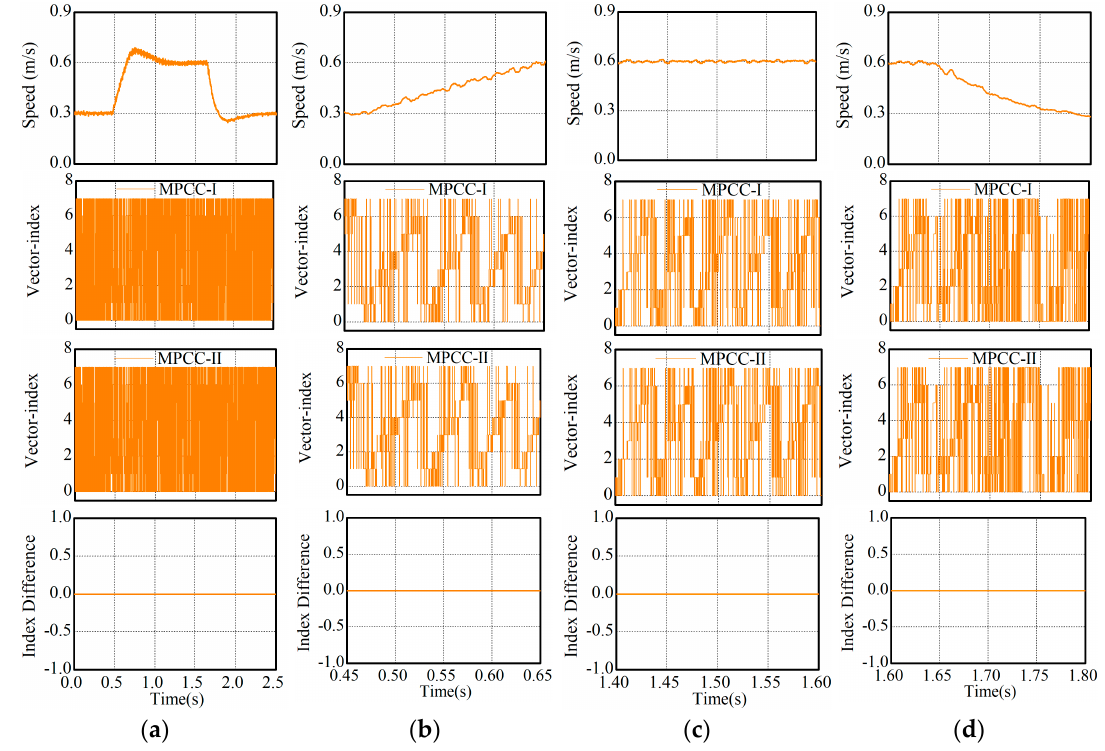
Figure 12. Comparison of VV selection by both MPCCs. ( a ) t = 0–2.5 s, ( b ) t = 0.5–0.70 s, ( c ) t = 1.4–1.6 s, and ( d ) t = 1.7–1.9 s.